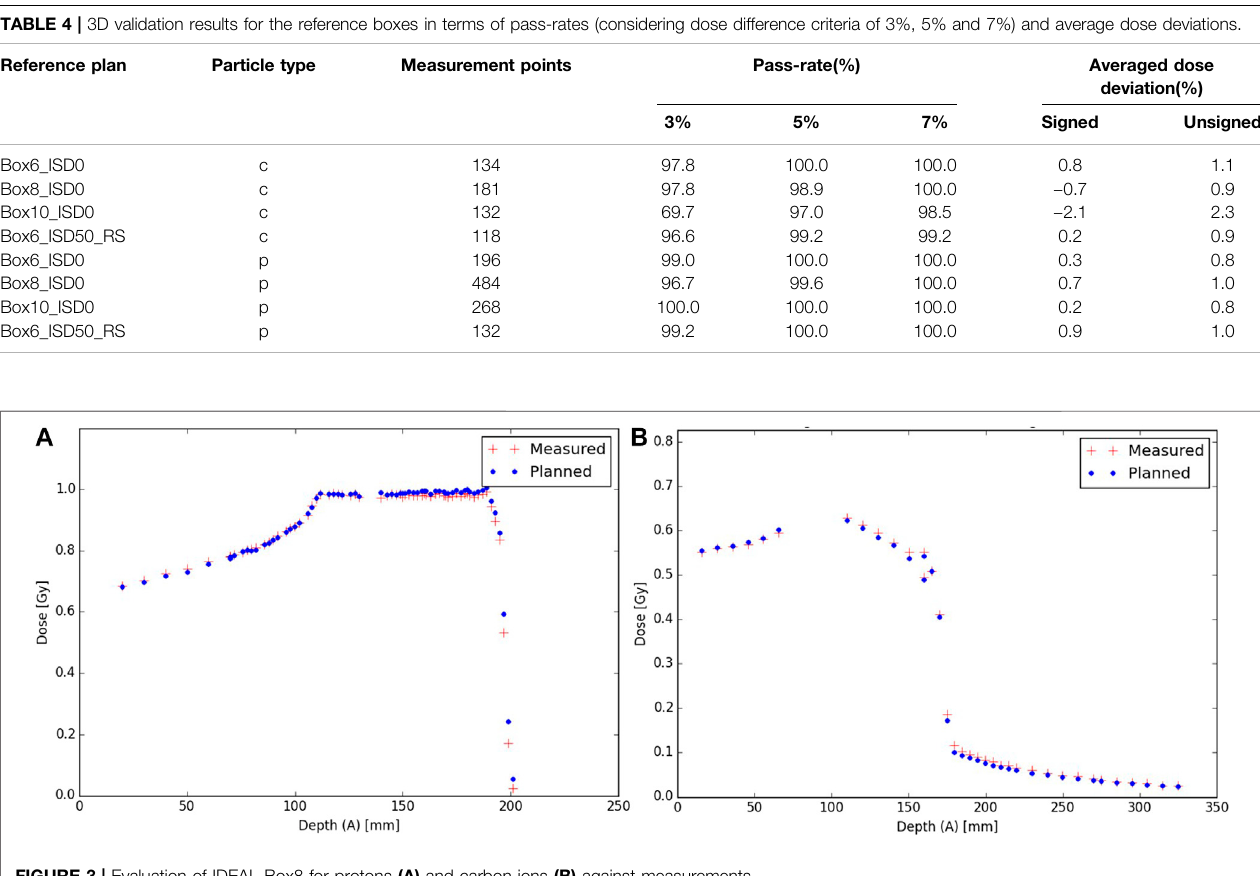
FIGURE 3 | Evaluation of IDEAL Box8 for protons (A) and carbon ions (B) against